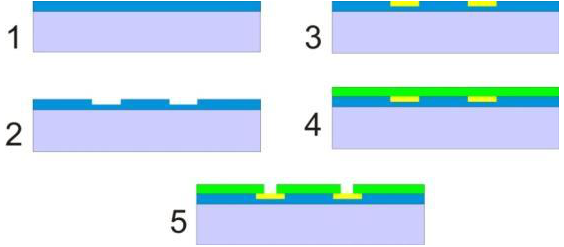
Figure 2. Summary of the optimised fabrication process. ( 1 ) 500 nm silicon dioxide are deposited on a silicon wafer; ( 2 ) The electrodes are patterned by photolithography and a HF dip creates undercuts at the locations where the metals are to be deposited; ( 3 ) 10 nm Ti and 150 nm Au are deposited by a thermal evaporation process and the electrodes are formed by lift-off; ( 4 ) 500 nm of silicon nitride are deposited by PECVD; ( 5 ) The nitride layer is patterned by photolithography and etched with RIE to open the electrode areas and the contact